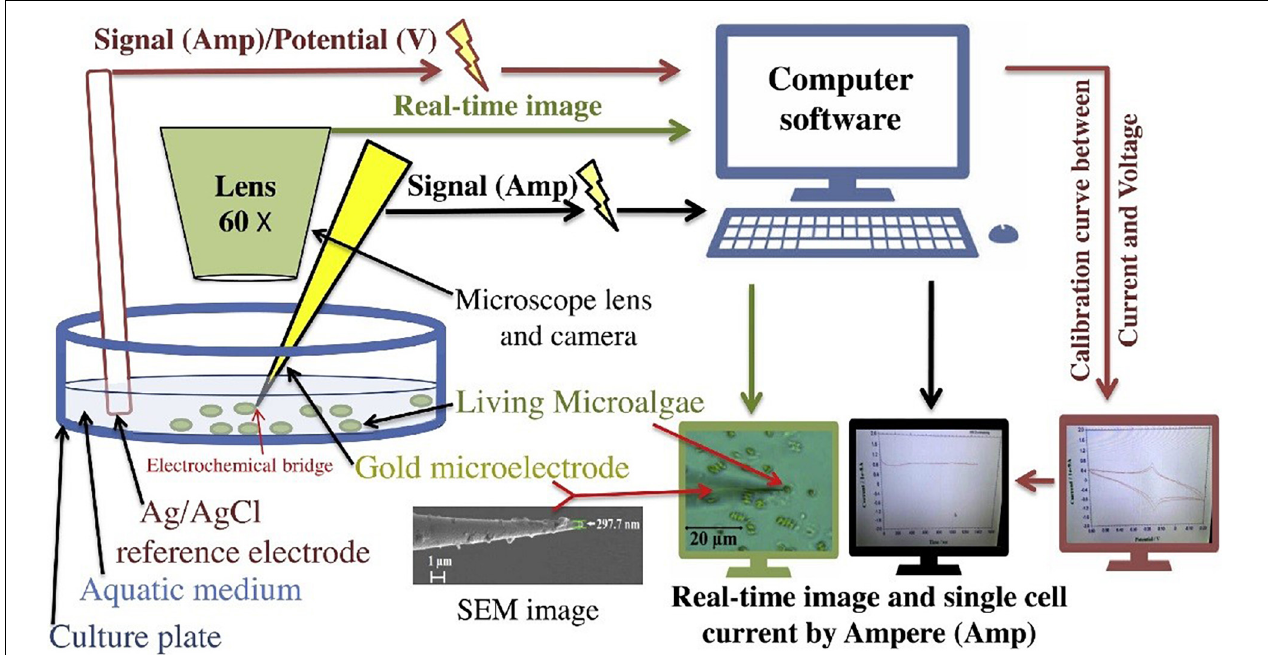
FIGURE 9 | Illustration of microalgae single-cell electric current analytical detection by gold microelectrode (2) (Copyright permission: